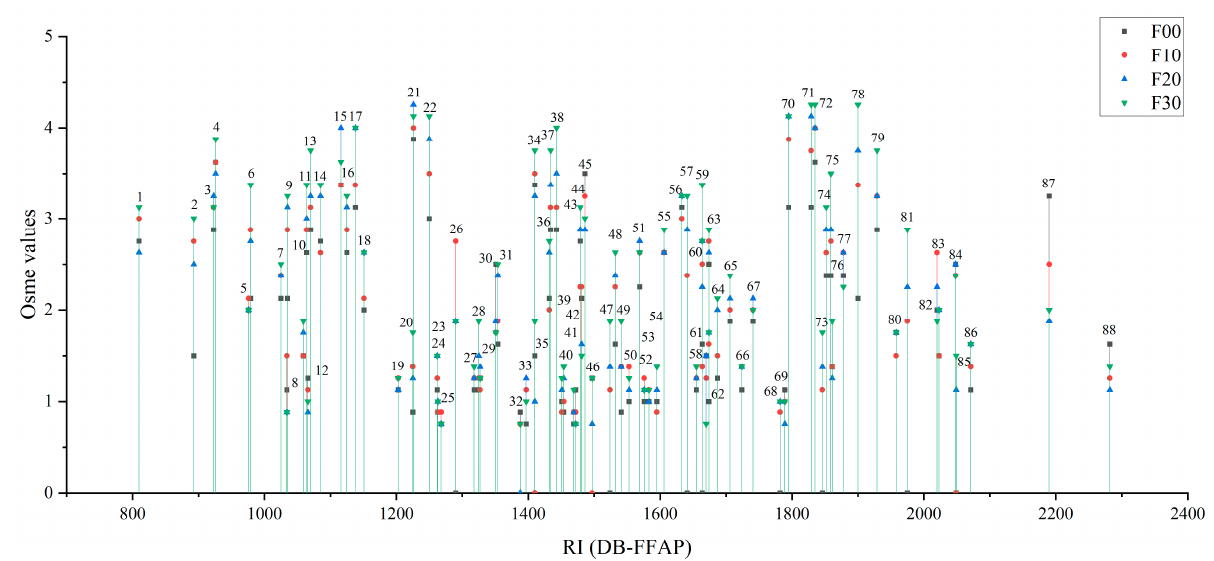
Figure 1. Osme value comparison of four different grades of FJ. Notations: The number on the peak corresponds to Table 1, the abscissa represents the retention index of the compounds on the DB-FFAP chromatographic column, and the ordinate represents the aroma intensity of the compounds.